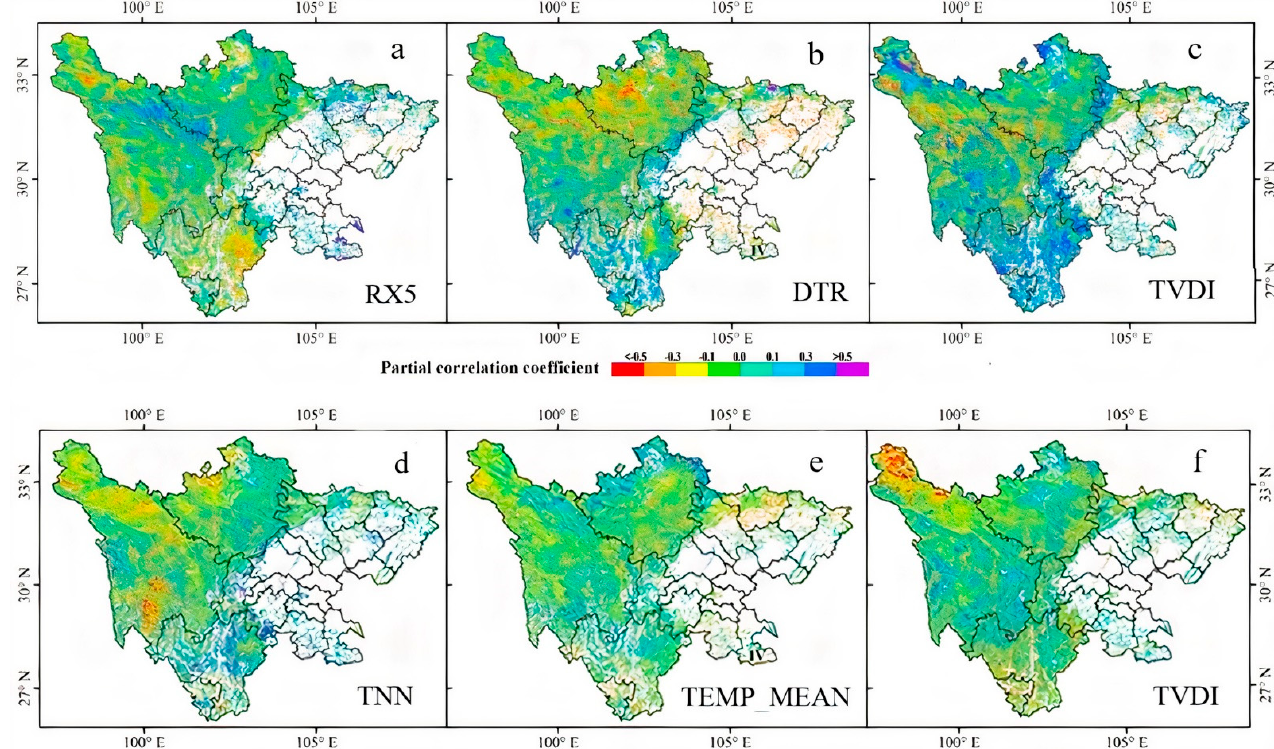
Figure 7. The sensitivity of vegetation phenology in Sichuan Province to extreme climate indices. The proportion of pixels with p < 0.01 is less than 10%. The sensitivity response of start of the growing season (SOS) to RX5 ( a ), the sensitivity response of SOS to DTR ( b ), the sensitivity response of SOS to TVDI ( c ), the sensitivity response of end of the growing season (EOS) to TNN ( d ), the sensitivity response of EOS to TEMP_MEAN ( e ), the sensitivity response of EOS to TVDI ( f ).